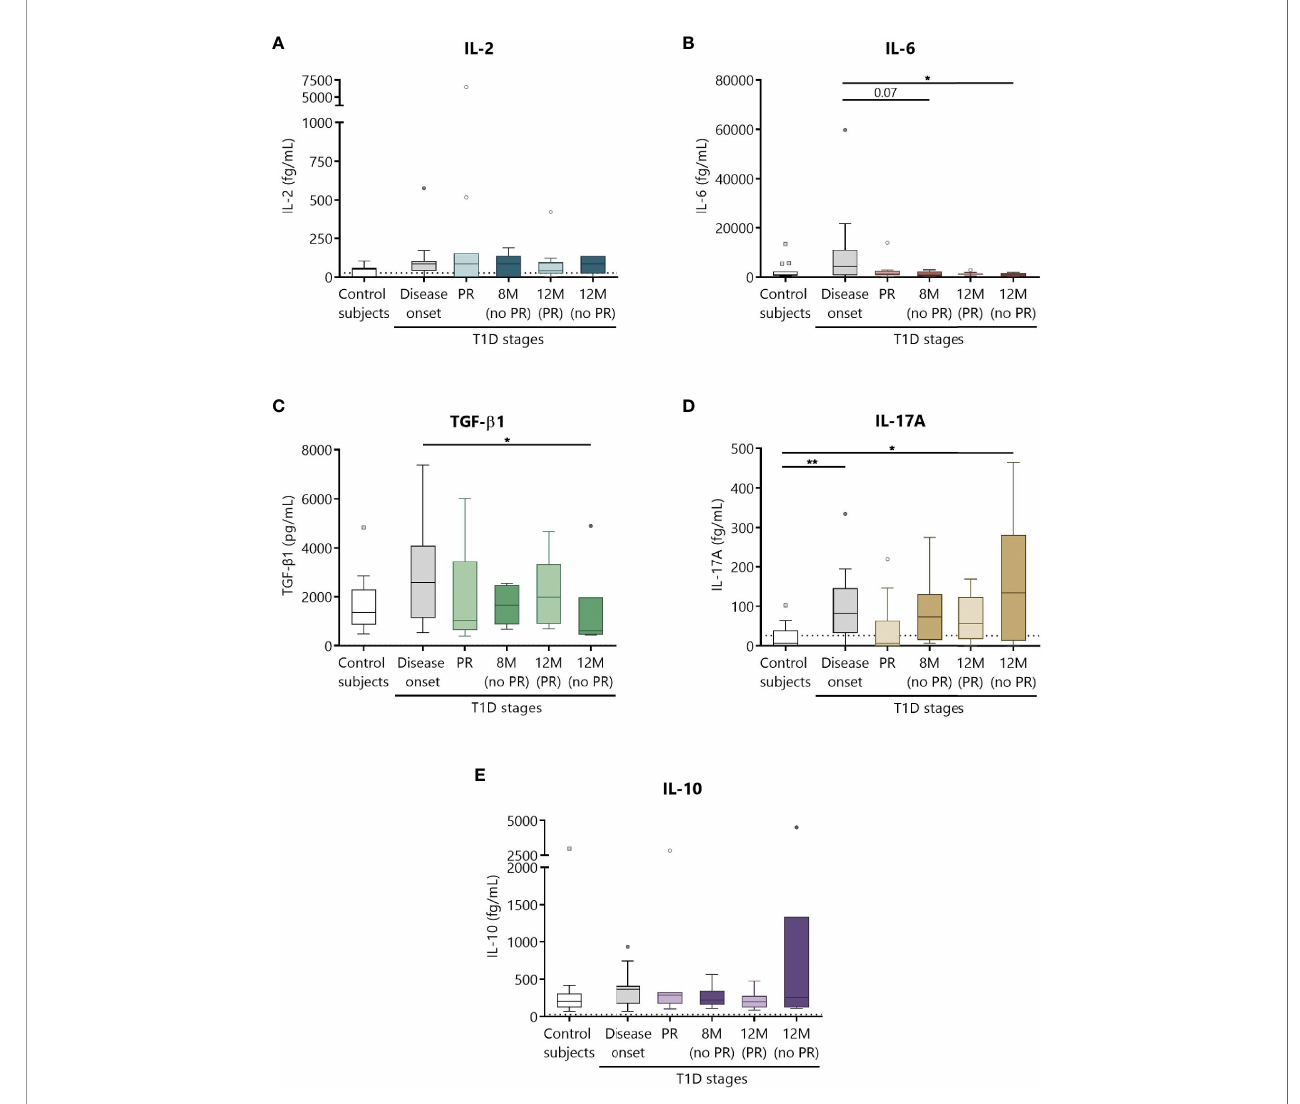
FIGURE 8 | Circulating cytokine concentrations at different stages of T1D. Plasma from control subjects and patients with T1D at different time-points was obtained to quantitatively determine the concentrations of (A) IL-2, (B) IL-6, (D) IL-17A, and (E) IL-10 by CBA and of (C) TGF- b 1 by ELISA. Uncolored boxes represent controls ( n = 17), and patients are represented by gray boxes at disease onset ( n = 17), light-colored boxes at PR ( n = 11) and for remitter patients at 12 months (12 M PR) ( n = 10), and dark-colored boxes for non-remitter patients at 8 months (8 M no PR) ( n = 6) and 12 months (12 M no PR) ( n = 6). Data are presented as box- and-whisker plots. Boxes indicate the fi rst and third quartiles. The horizontal bar in the box indicates the median. Whiskers are drawn using Tukey ’ s criteria of 1.5× the interquartile range. Outliers beyond the whiskers are shown. * P ≤ 0.05, ** P < 0.01 after mixed effects model with Tukey ’ s post-hoc test for longitudinal data, or Kruskal – Wallis with Dunn ’ s post-hoc test for comparisons between control subjects and the different T1D time-points. P ≤ 0.05 is considered signi fi